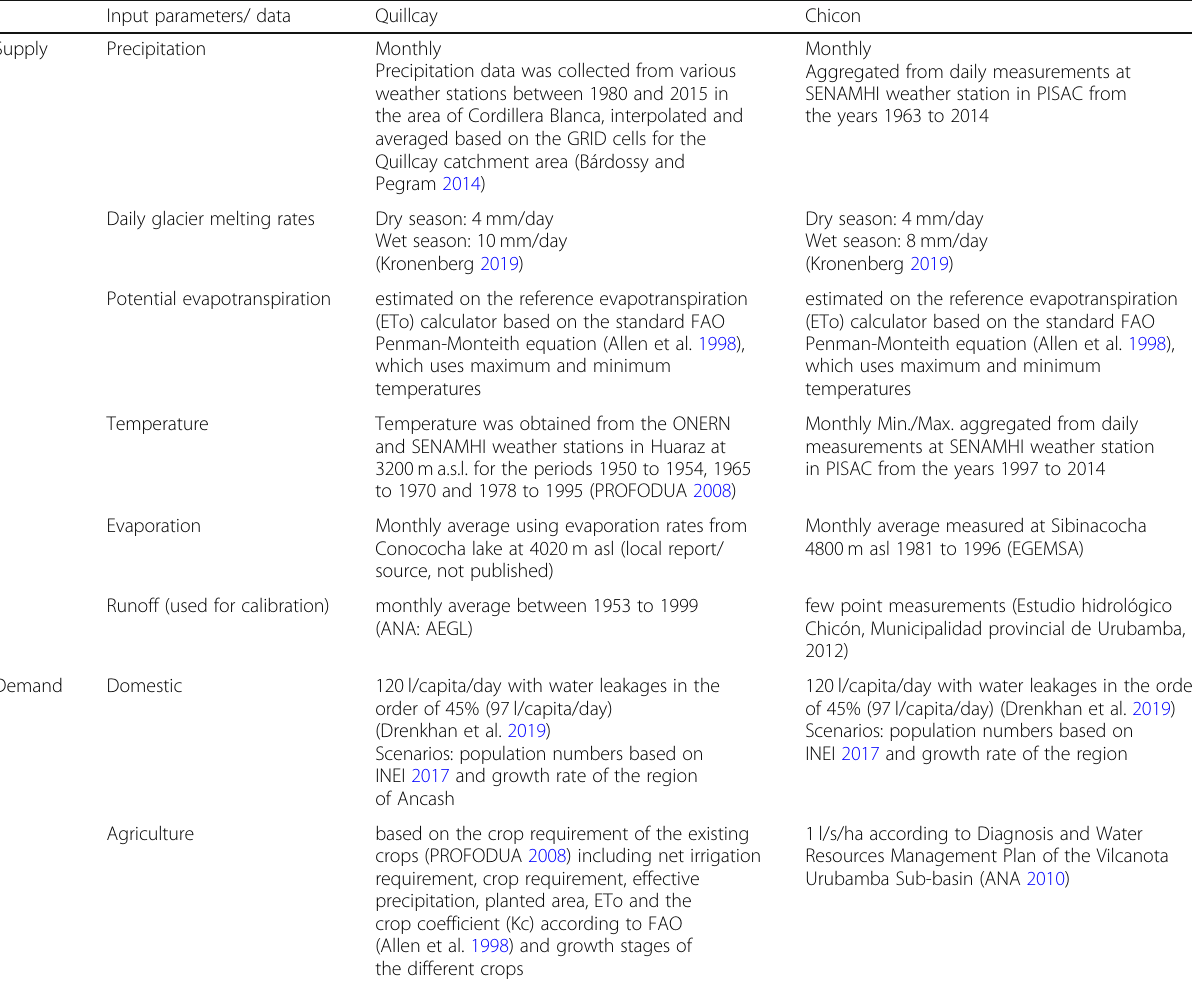
Table 1 Input parameters and data for Quillcay and Chicon for the hydrological balance model based on Temez Input parameters/